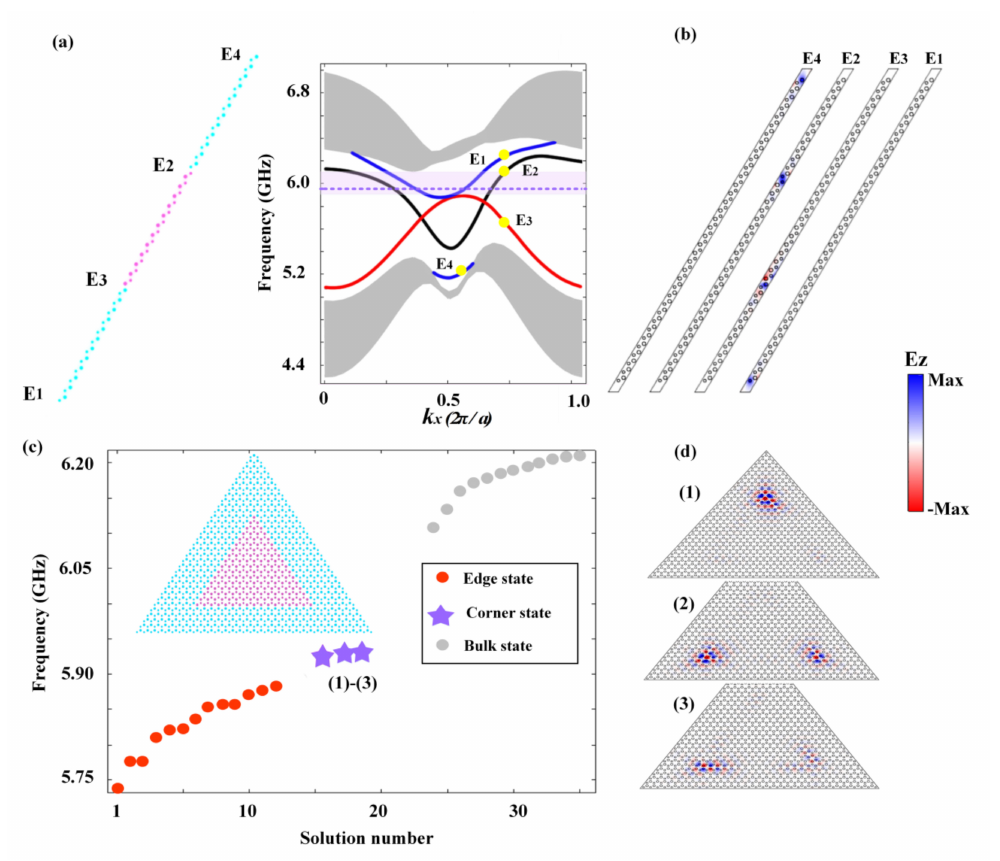
Figure 2. Anti-chiral edge states and the associated topological corner states. ( a ) Left panel: A strip supercell composed of PC1 (blue regions) and PC2 (pink region), which presents four edges